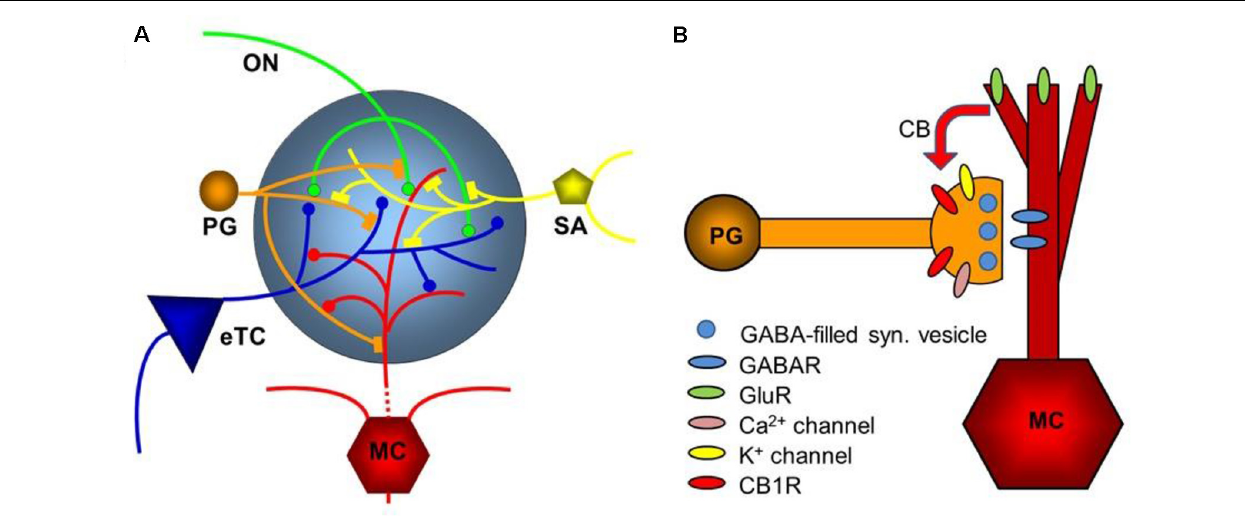
FIGURE 5 | Diagram of the glomerular network. (A) Olfactory nerve (ON) afferents enter the main olfactory bulb through the olfactory nerve laver to synapse with periglomerular cells (PG), mitral cells (MC), and tufted cells (of which only external ones, eTCs, are shown) within the glomerular layer. Periglomerular cells inhibit olfactory nerve terminals, external tufted cells, and mitral cells. The processes of Short Axon (SA) cells, which are GABAergic and dopaminergic, receive excitatory synaptic input and form extensive interconnections between glomeruli. Mitral cell apical dendrites convey sensory information to deeper layers of the main olfactory bulb. Mitral cells and tufted cells form dendrodenritic synapses with glomerular neuronal processes. ( B) Dendrodendritic interactions of mitral cells and periglomerular cells. Cannabinoids are released non-synaptically by mitral and potentially other cells and act on cannabinoid receptors in periglomerular cells to modulate their synaptic release of GABA. Only the apical dendrite of the mitral cell is shown. GABAR—GABA receptors, GluR—ionotropic and metabotropic glutamate receptors. Panel (A) is modified from Harvey and Heinbockel (2018) with the permission of the publisher MDPI. Panel (B) is from Wang et al.